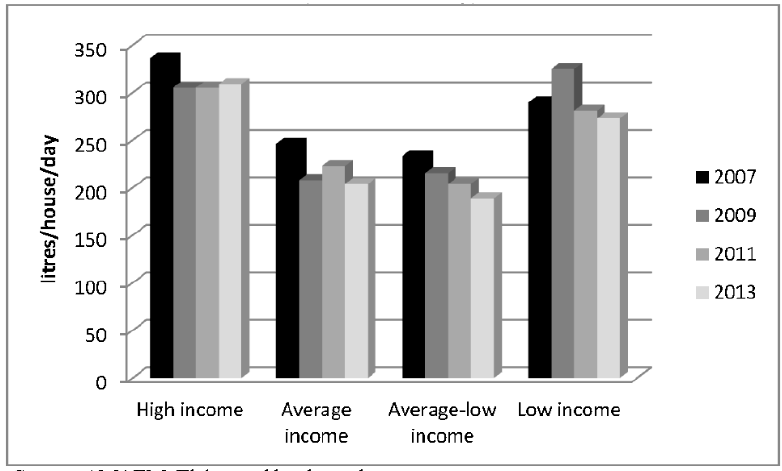
Figure 4. Evolution of domestic water consumption by economic rent in the urban core of the city of Alicante (liters/house/day), 2007–2013.